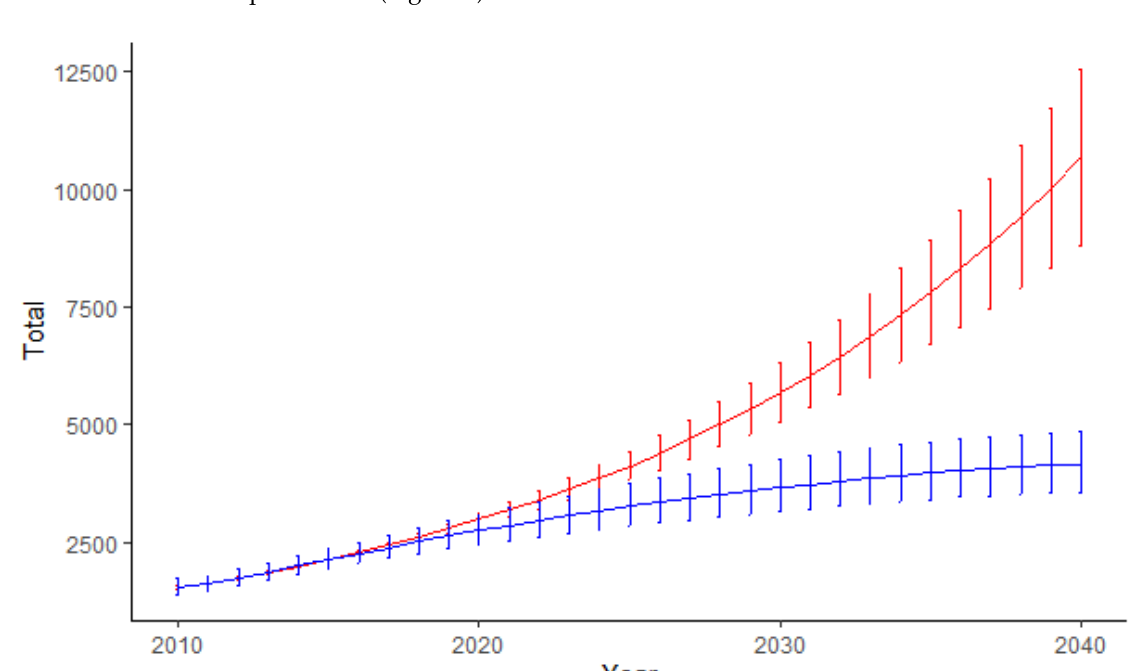
Figure 6. Projections for revision shoulder arthroplasty procedures using a “constant-rate” approach based on a Poisson (red) and a negative binomial regression model using a monotone B-spline approach (blue).